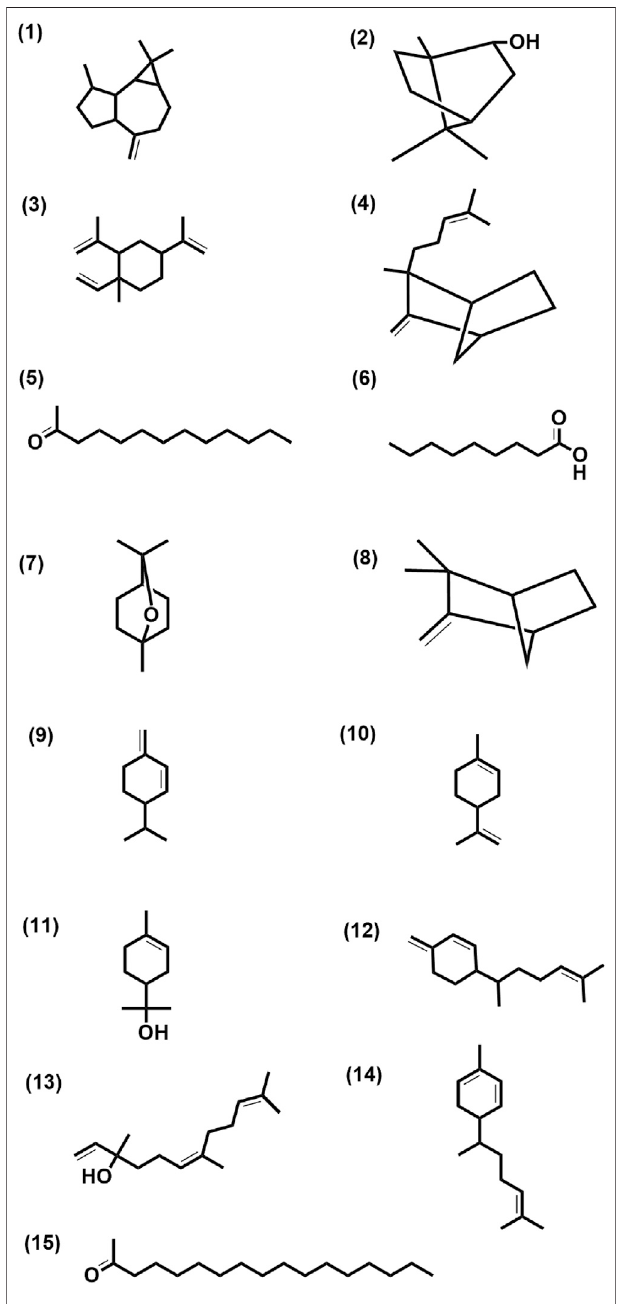
FIGURE 3 | Structure of few selected cultivar-speci fi c (panel numbers 1 – 7 corresponding to serial numbers 24 – 30 of Table 2 ); detected in more than one cultivar (panel numbers 8 – 13 corresponding to serial numbers 13 – 18 of Table 3 ) and common (panel numbers 14 – 15 corresponding toserialnumbers10and13of Table4 )compoundsalreadyreportedfromthe genus Curcuma in essential oils isolated from rhizomes by GCMS analysis of seven cultivars of Curcuma L.: fi ve of Curcuma longa L. (cvs. Alleppey Supreme, Duggirala Red, Prathibha, Salem, and Suguna) and two of C. aromatica Salisb. (cvs. Kasturi Araku and Kasturi Avidi). (1) Aromadendrene, (2) isoborneol, (3) β -elemene, (4) α -santalene, (5) 2-tridecanone, (6) nonanoic acid, (7) eucalyptol, (8) camphene, (9) α -phellandrene, (10) limonene, (11) α -terpineol,(12) β -sesquiphellandren,(13)nerolidol,(14) α -zingiberene, (15)2-